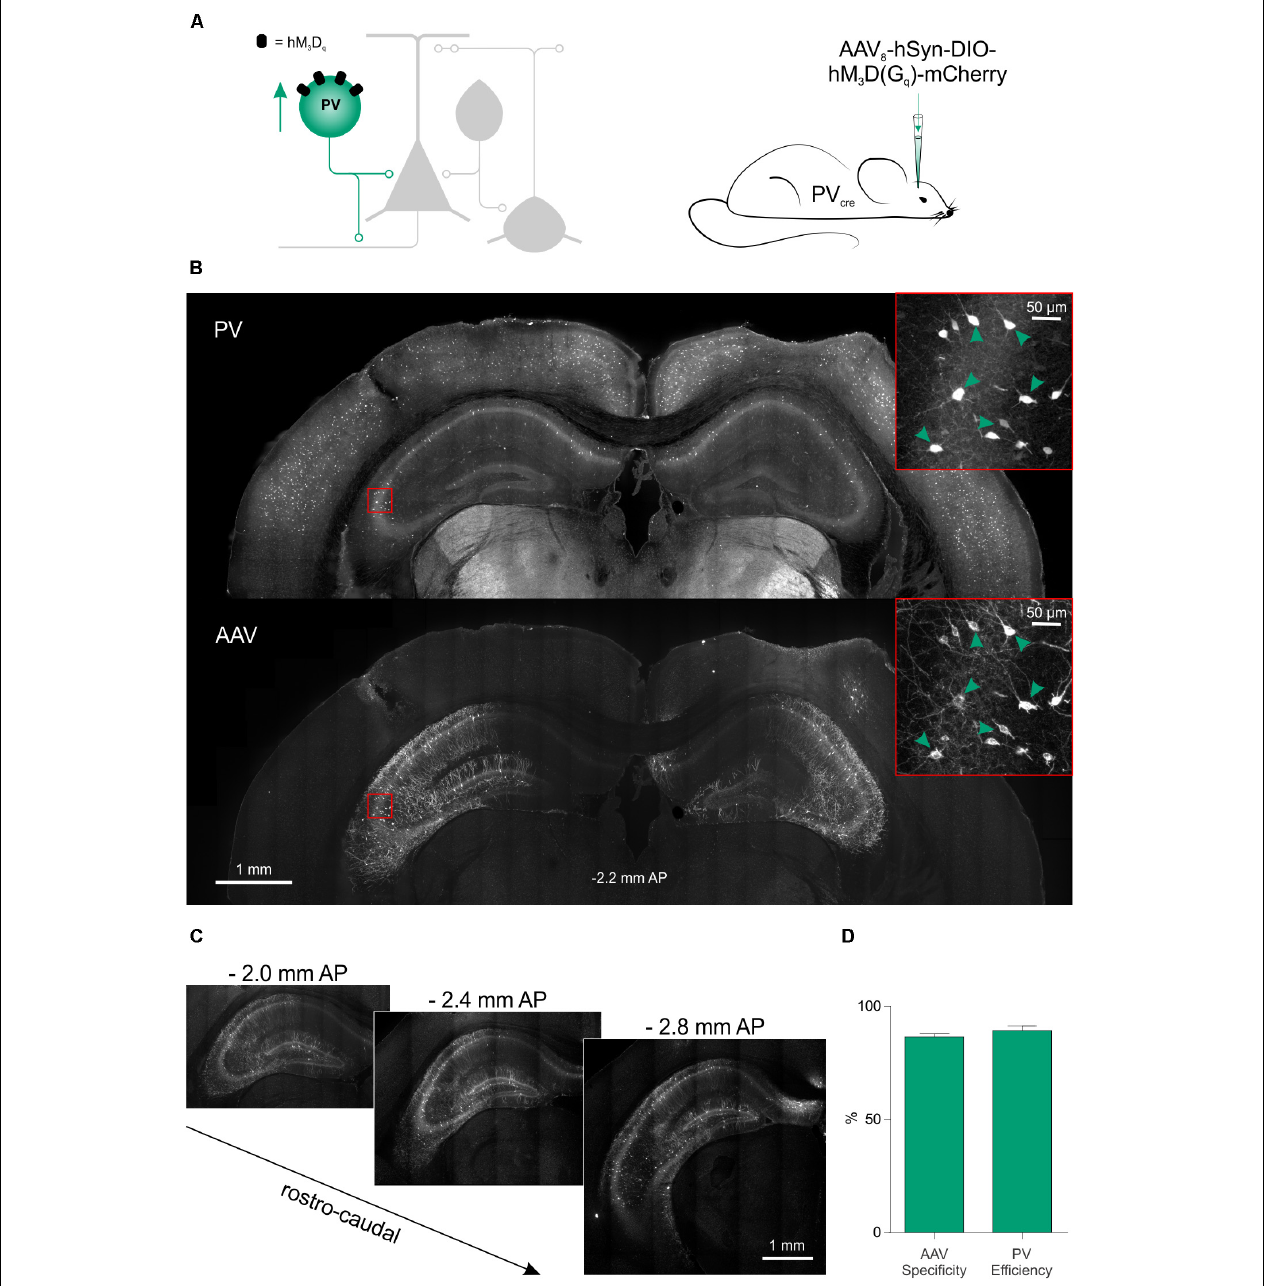
FIGURE 6 | Excitatory DREADDs can be specifically and efficiently targeted to hippocampal PV interneurons in vivo . (A) To deliver hM 3 D q receptors to PV interneurons in vivo (left), PV-cre mice received bilaterally injections of AAV 8 -hSyn-DIO-hM 3 D q -mCherry into the ventral and dorsal hippocampus (right). (B) Immunohistochemical characterization confirmed that hippocampal PV interneurons (‘PV,’ top) were efficiently transduced with hM 3 D q -mCherry (‘AAV,’ bottom). Insets in red squares indicate cells co-expressing PV and hM 3 D q -mCherry (arrow heads). (C) Serial sections illustrate extensive AAV spread and hM 3 D q -mCherry expression throughout the hippocampus. AP, anteroposterior. (D) Population data showing high targeting specificity and efficiency of the hM 3 D q -mCherry expression in PV interneurons ( N = 7